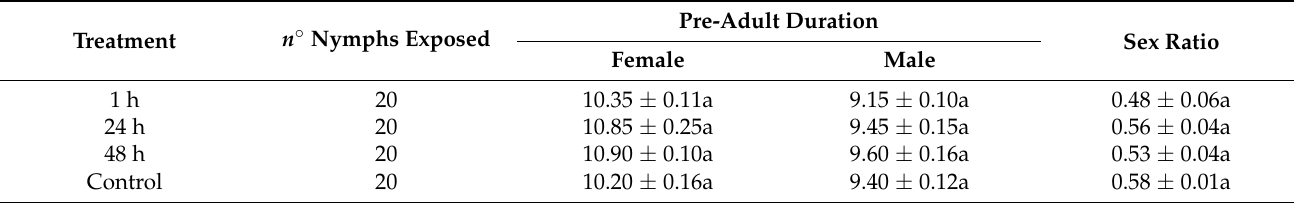
Means in the same column with the same letter are not significantly different (Tukey, p <